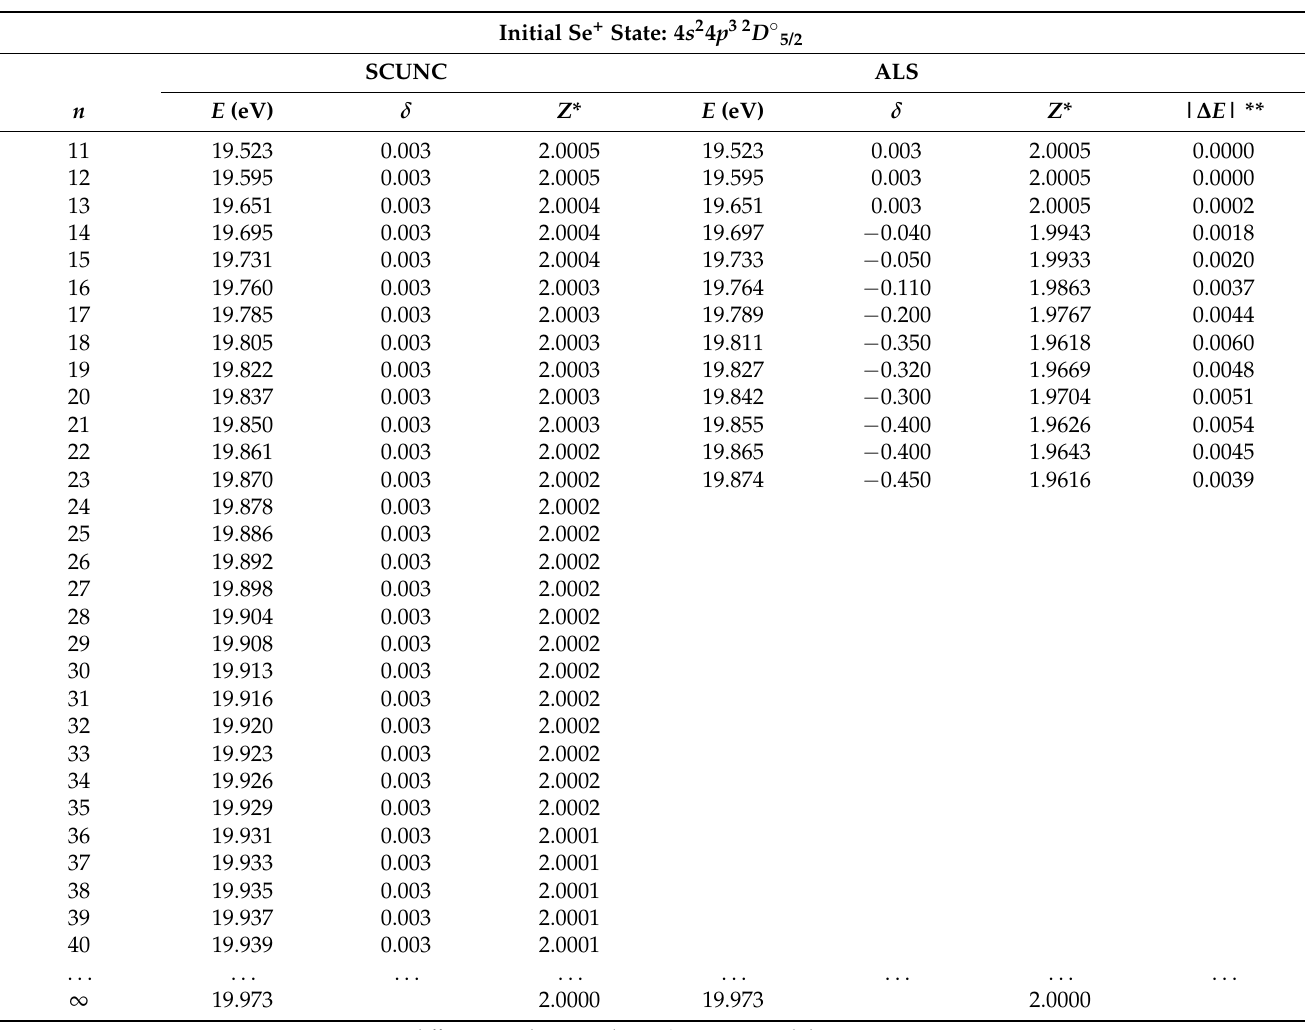
Table 7. Energy resonances ( E ), quantum defect ( δ ) and effective charge ( Z *) of the 4 s 2 4 p 2 ( 3 P 2 ) nd Rydberg series originating from the 4 s 2 4 p 3 2 D ◦ 5/2 metastable state of Se + converging to the 3 P 2 series limit in Se 2+ . The present results (SCUNC) are compared with the experimental data from ALS measurements [6]. The uncertainties in the experimental energies are stated to be ± 0.010 eV, f 1 ( 3 P 2 ; 2 D ◦ − 0.005 ± 0.001 with ν = 5/2 ) =